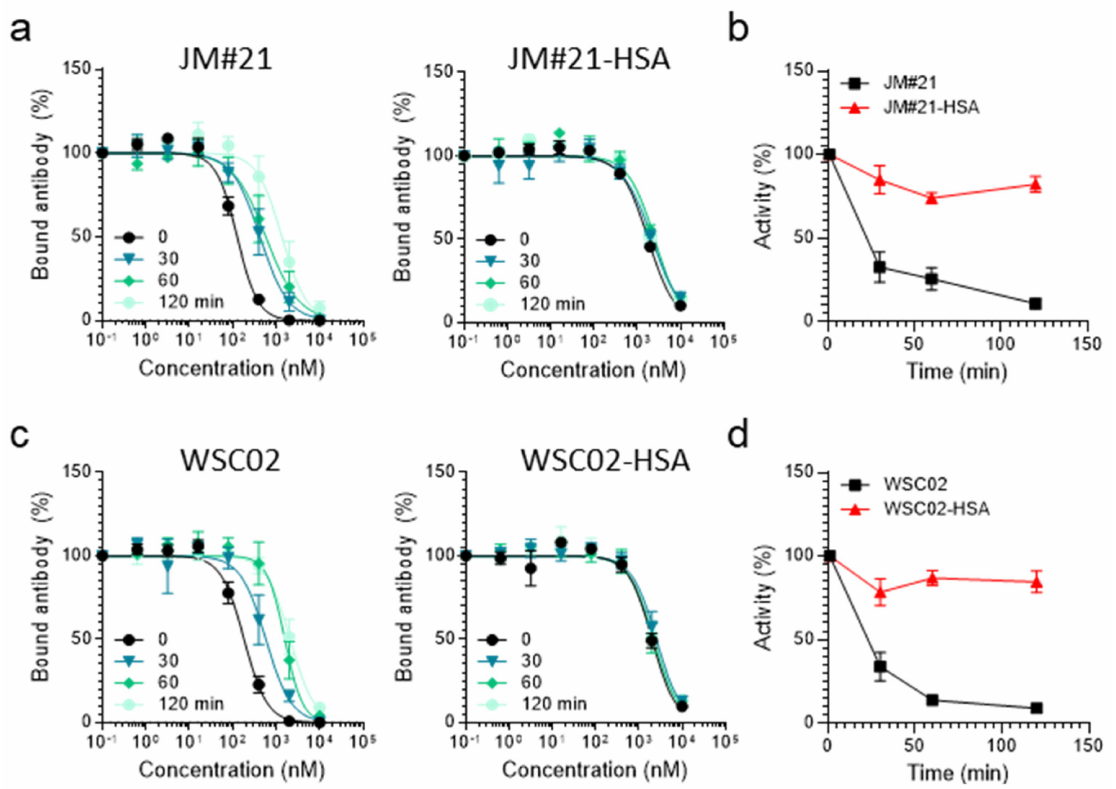
Figure 7. Peptides that are covalently coupled to HSA are protected against enzymatic degradation in whole human plasma as determined by functional antibody competition assay. JM#21 or JM#21 conjugates ( a ) or WSC02 or WSC02 conjugates ( c ) were spiked into human plasma and incubated at 37 ◦ C and remaining activity analyzed in the antibody competition assay. IC 50 values were determined by non-linear regression curve fit in GraphPad Prism. Remaining activity of JM#21 and JM#21-HSA ( b ) as well as of WSC02 and WSC02-HSA ( d ) was determined by IC 50 (t) / IC 50 (t = 0) × 100) and half-lives determined by one-phase decay. Data from at least three individual rounds of plasma incubation ± SEM are